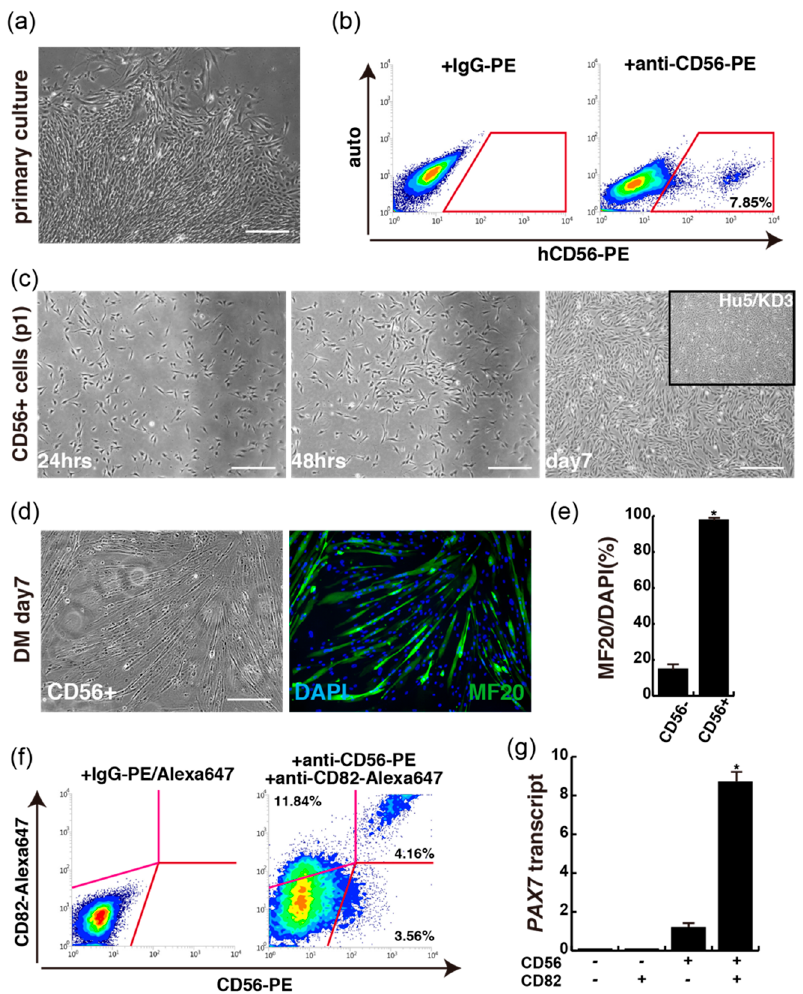
Figure 3. CD56 + CD82 + double-positive myogenic cells from primary cultured orbicularis oculi muscles. ( a ) Image of primary cultured cells digested from isolated eyelid tissue. ( b ) FACS profile for detecting CD56-positive cells from primary cultured cells with extra eyelid tissue. ( c ) Morphological features of CD56-sorted cells (passage 1, p1) of orbicularis oculi muscles, cultured for 24 h (24hrs), 48 h (48hrs), and 7 days (day7). ( d ) Myogenic di ff erentiation with CD56 + cells in 2% horse serum medium for 7 days (DM, day7). MF20, green; DAPI, blue. ( e ) The percentage of di ff erentiated myogenic cells is presented as MF20 / DAPI ratio. n = 3 independent replicates; p -values were determined by t -test from a two-tailed distribution. * p < 0.01. ( f ) FACS profile of CD56- and CD82- double positive cells from primary cultured orbicularis oculi muscles from extra eyelid tissue. ( g ) PAX7 transcriptome analyses of CD56 + CD82 + sorted cells shown in ( f ). n = 3 independent replicates; p -values are determined by Dunnett’s multiple-comparisons test. * p < 0.01. All scale bars, 100 µ